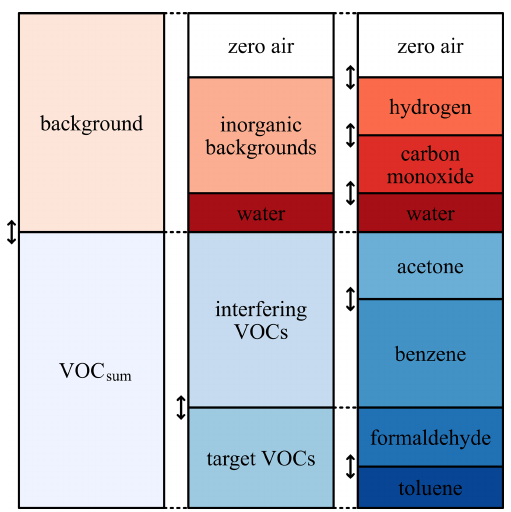
Figure 1. Schematic overview of the random gas mixture gener- ation. The scheme can be adapted to reflect different applications. Please note that this figure represents the measurement as it was actually performed, taking into account the accidental swapping of benzene (which should have been a target) and toluene (which should have been an interferent).